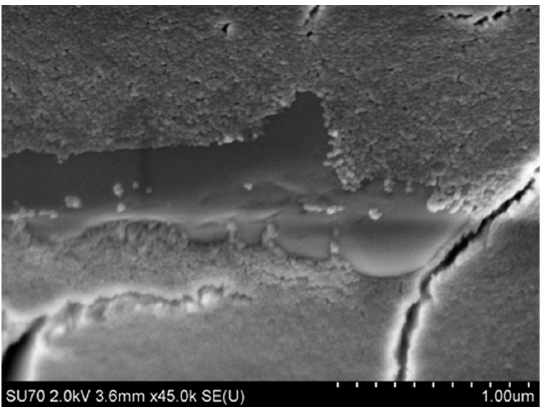
Figure 14. ZrO 2 powder grain surrounded by silica nanoparticles from the Ludox SK binder.